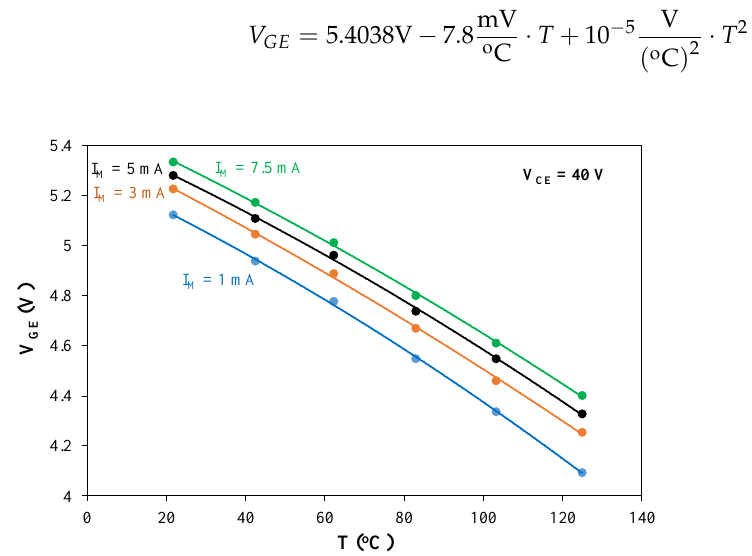
Figure 6. Thermometric characteristics of the anti-parallel diode for selected values of I M current. In turn, Figure 7 shows thermometric characteristics V GE (T) measured at selected val- ues of measurement current I M and V CE voltage equal to 40 V, which guarantees operation of the investigated transistor in the active mode. As is visible, these characteristics are nonlinear. They can be approximated with the use of the square function. For example,